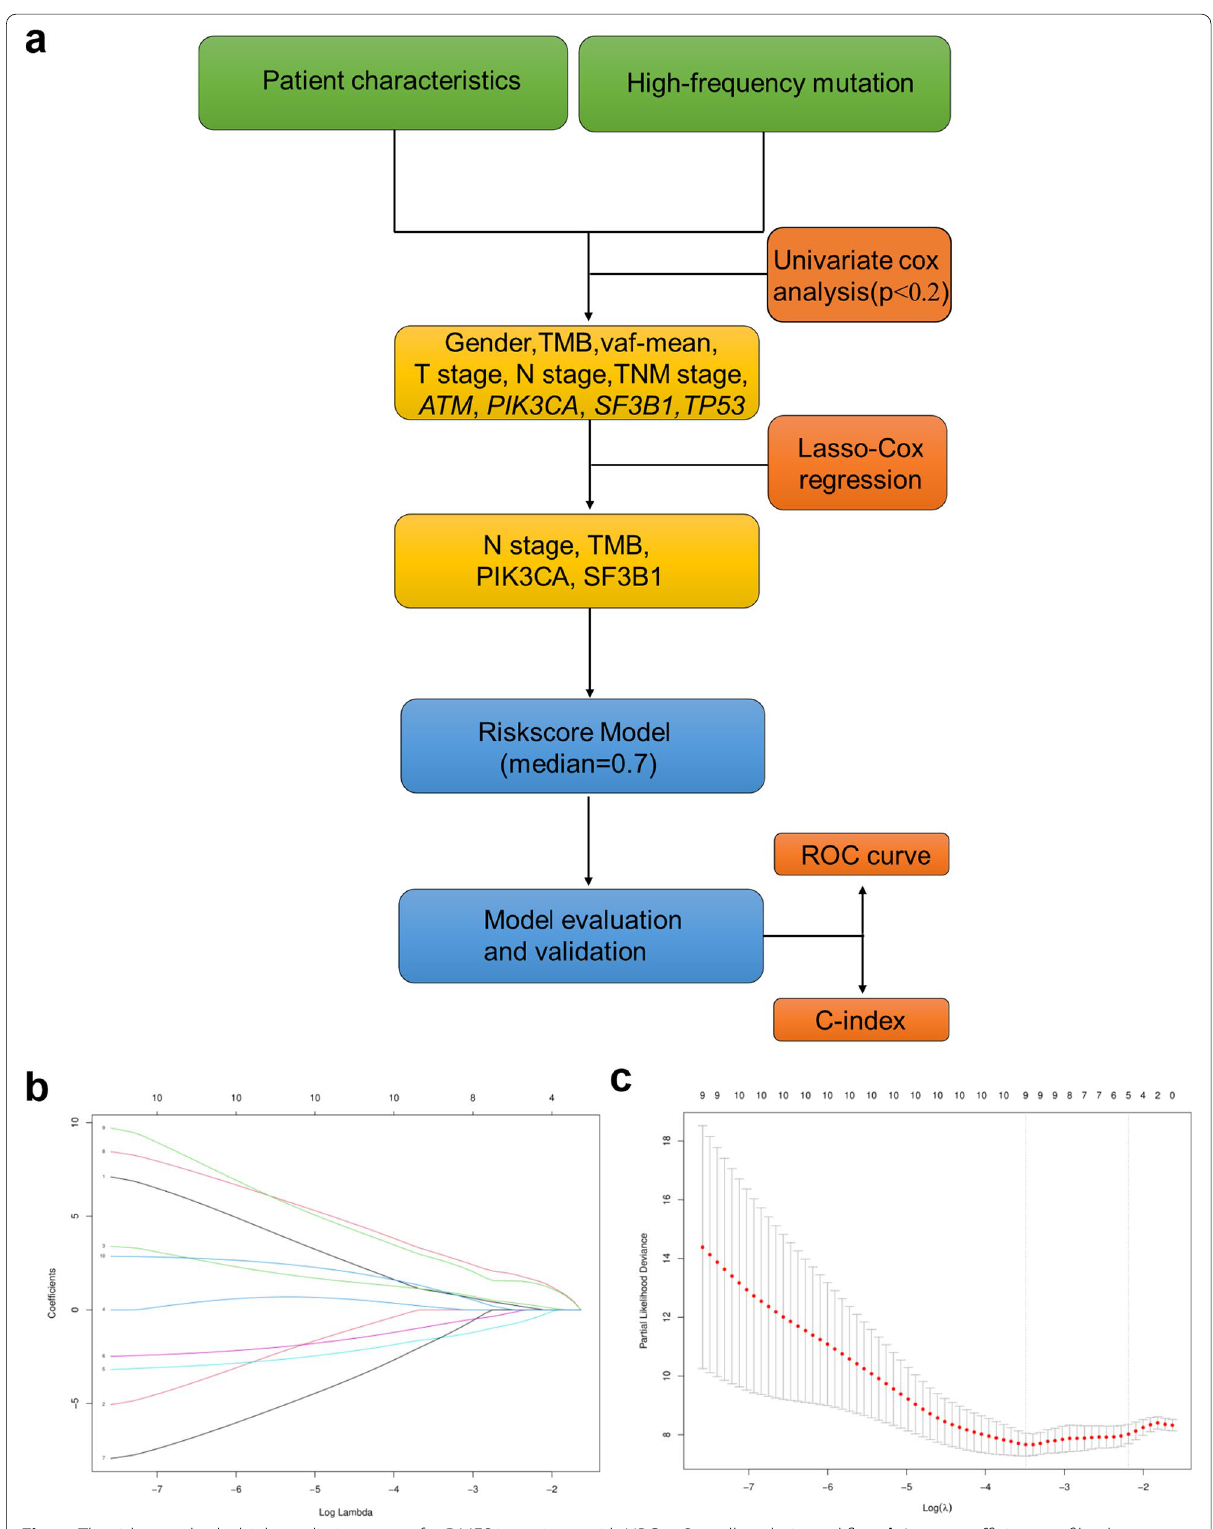
Fig. 5 The risk score had a high predictive power for DMFS in patients with NPC. a Overall analysis workflow. b Lasso coefficient profile plots showing that the variations in the size of the coefficients of parameters shrink with an increasing value of the k penalty. c Penalty plot for the Lasso model with error bars denoting the standard errors. d , f ROC curves of TNM stage and risk score in the training cohort and validation cohort. e , g Kaplan–Meier analysis of the risk score model in the training cohort and validation